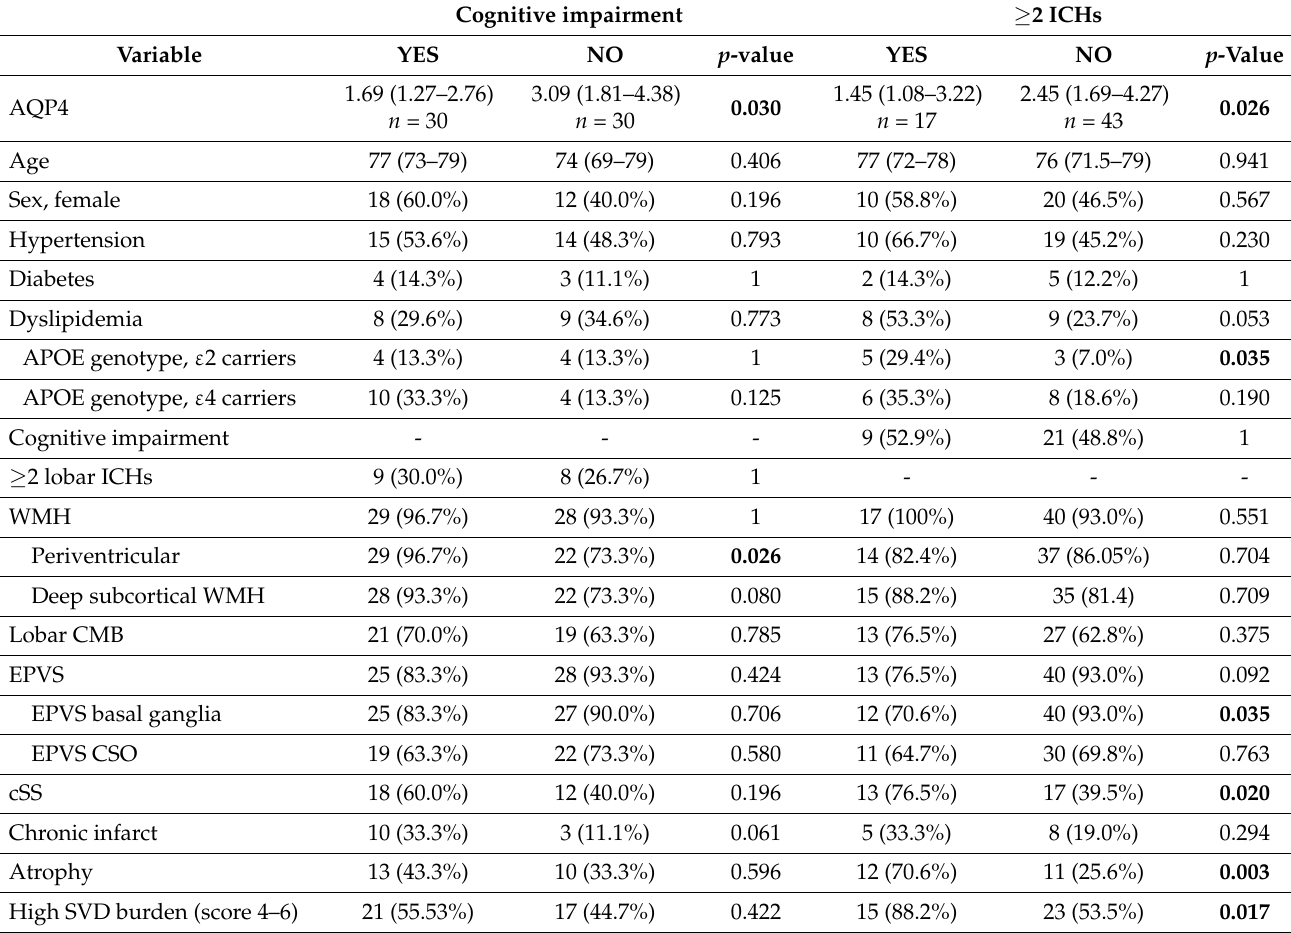
Table A1. Univariate analysis of the variables associated with cognitive impairment and ≥ 2 ICHs.